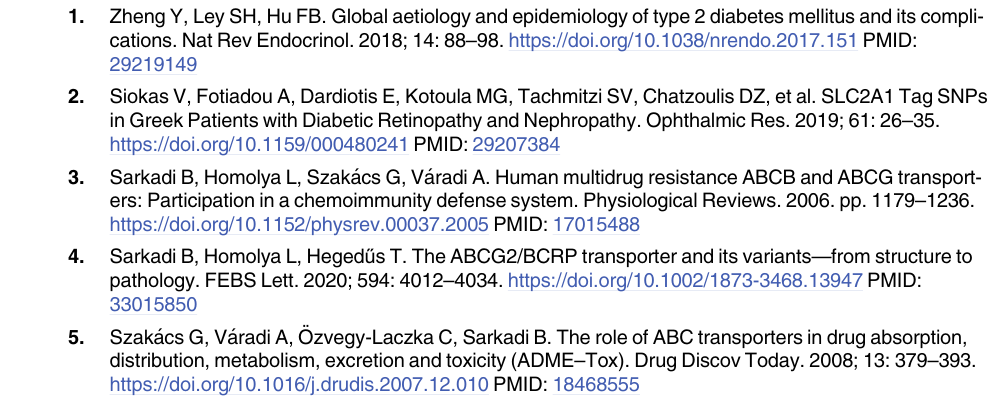
S3 Fig. The forest plot shows the phenome-wide association of ABCG2-Q141K for uric acid, HbA1c and fasting glucose traits. The PheWAS associations were generated by bottom- line meta-analysis across all datasets in the Type 2 Diabetes Knowledge Portal (https://t2d. hugeamp.org). The color of the cubes shows the p values (red: p � 5.00e-8, pink: 5.00e-